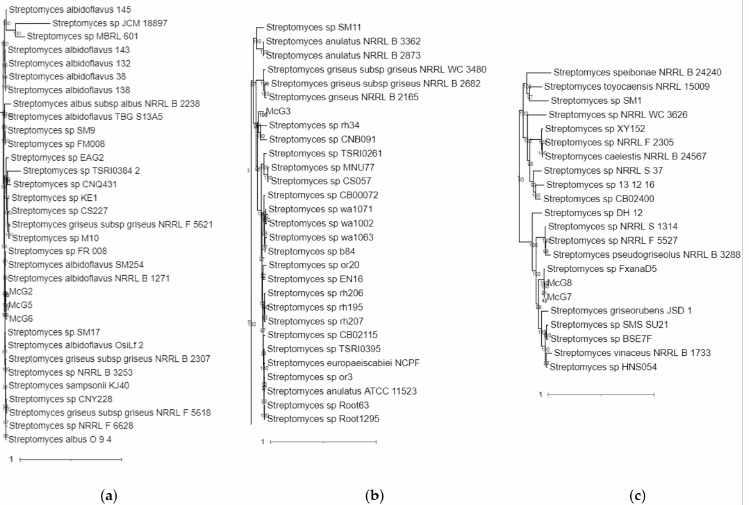
Figure 3. Phylogenetic relationships between ( a ) Streptomyces isolates McG2, McG5, and McG6; ( b ) Streptomyces isolate McG3; and ( c ) Streptomyces isolates McG7 and McG8 using maximum- likelihood phylogeny. Phylogenies were reconstructed in FastTree MP and rendered in